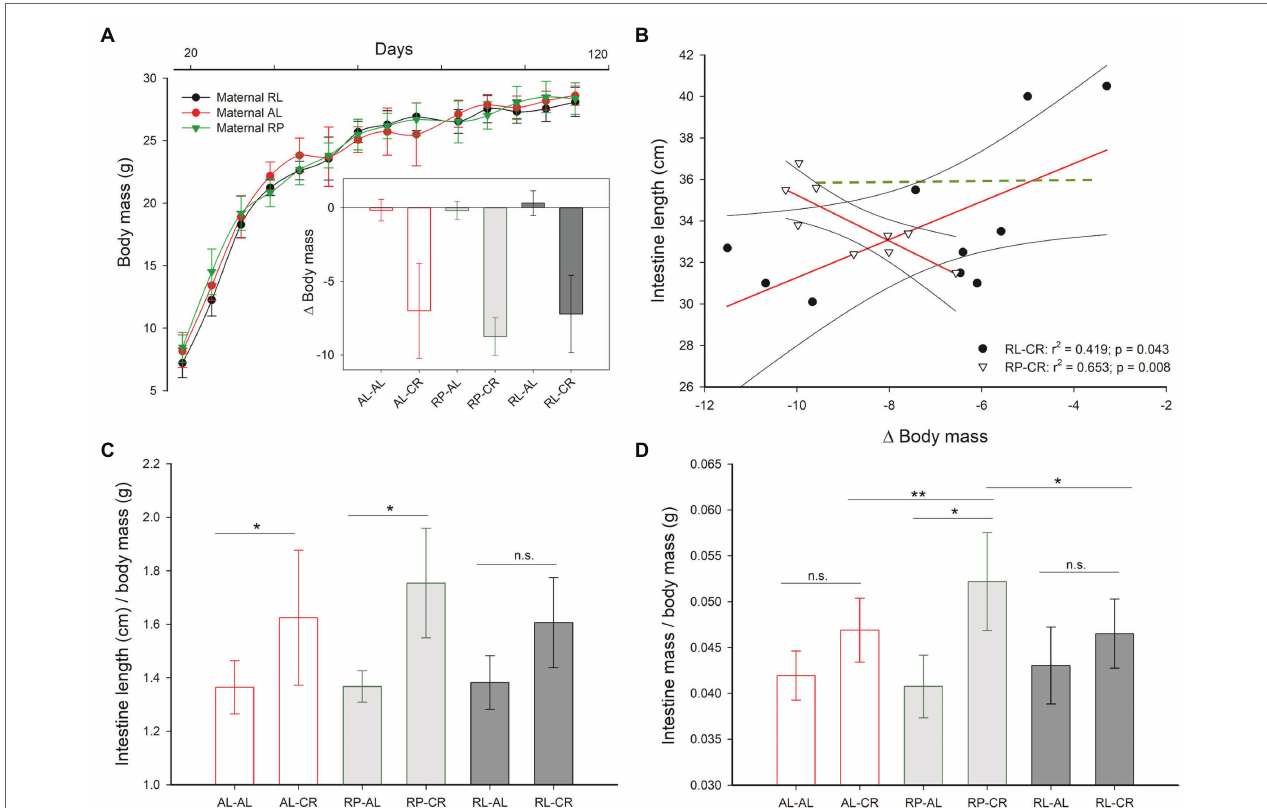
FIGURE 2 | (A) Body mass increment under three perinatal feeding conditions and body mass change, under adult CR versus ad libitum control. (B) Correlation analysis between body mass changes and intestine length for RP-CR and RL-CR groups (all other treatments in green, p > 0.05). (C,D) Detailed analysis of intestine length and mass of offspring after perinatal and adult treatments as indicated. One asterisk: p < 0.05; two asterisks: p =